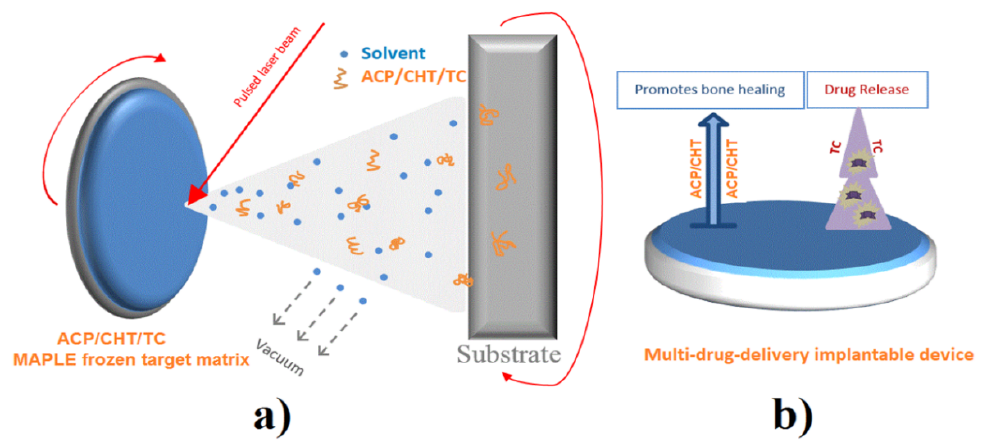
Figure 1. ( a ) MAPLE experimental scheme and ( b ) multi-drug delivery implantable